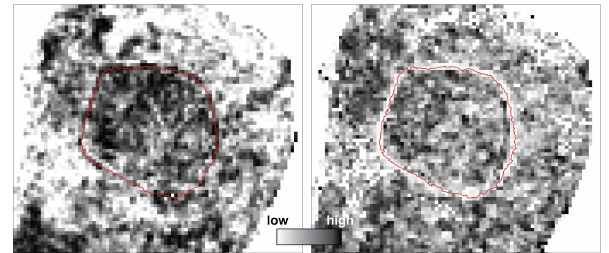
Figure 9. Northern circle. Maximum correlation coefficients (left) and signal-to-noise ratio (SNR, right) of the image matching of Fig. 8. SNR is defined as the ratio between the maximum corre- lation coefficient and the average correlation coefficient for each individual match. Transition between fine domain and surrounding gravel rings indicated in